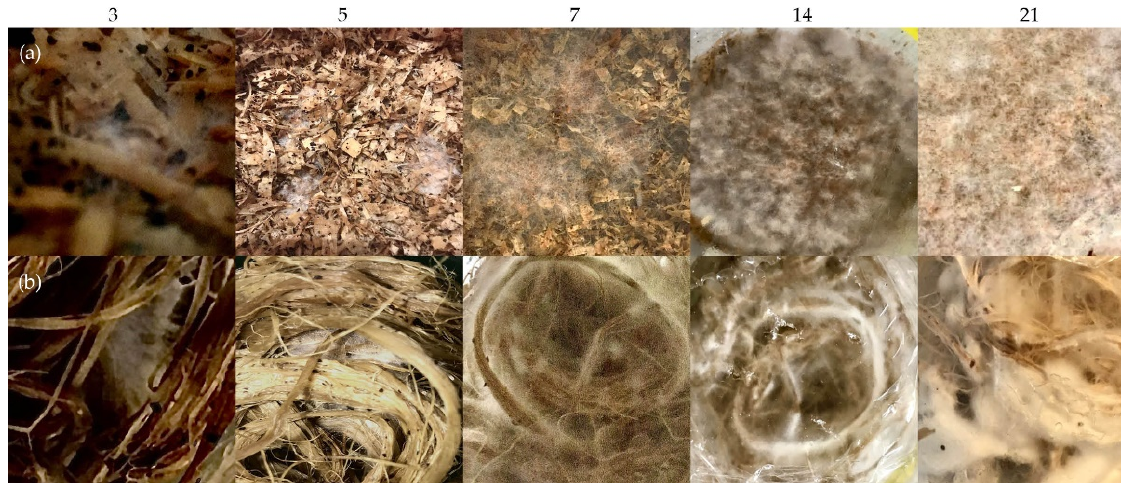
Figure 4. Growth process in days: ( a ) wood chips, ( b ) hemp fibers.